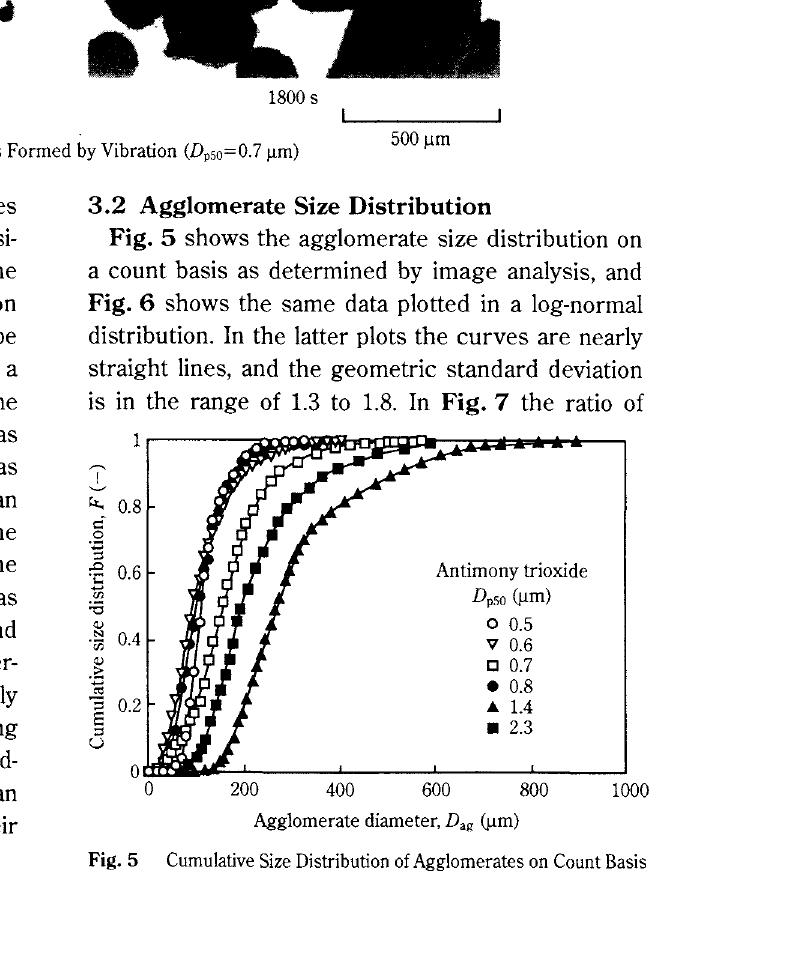
Cumulative Size Distribution of Agglomerates on Count